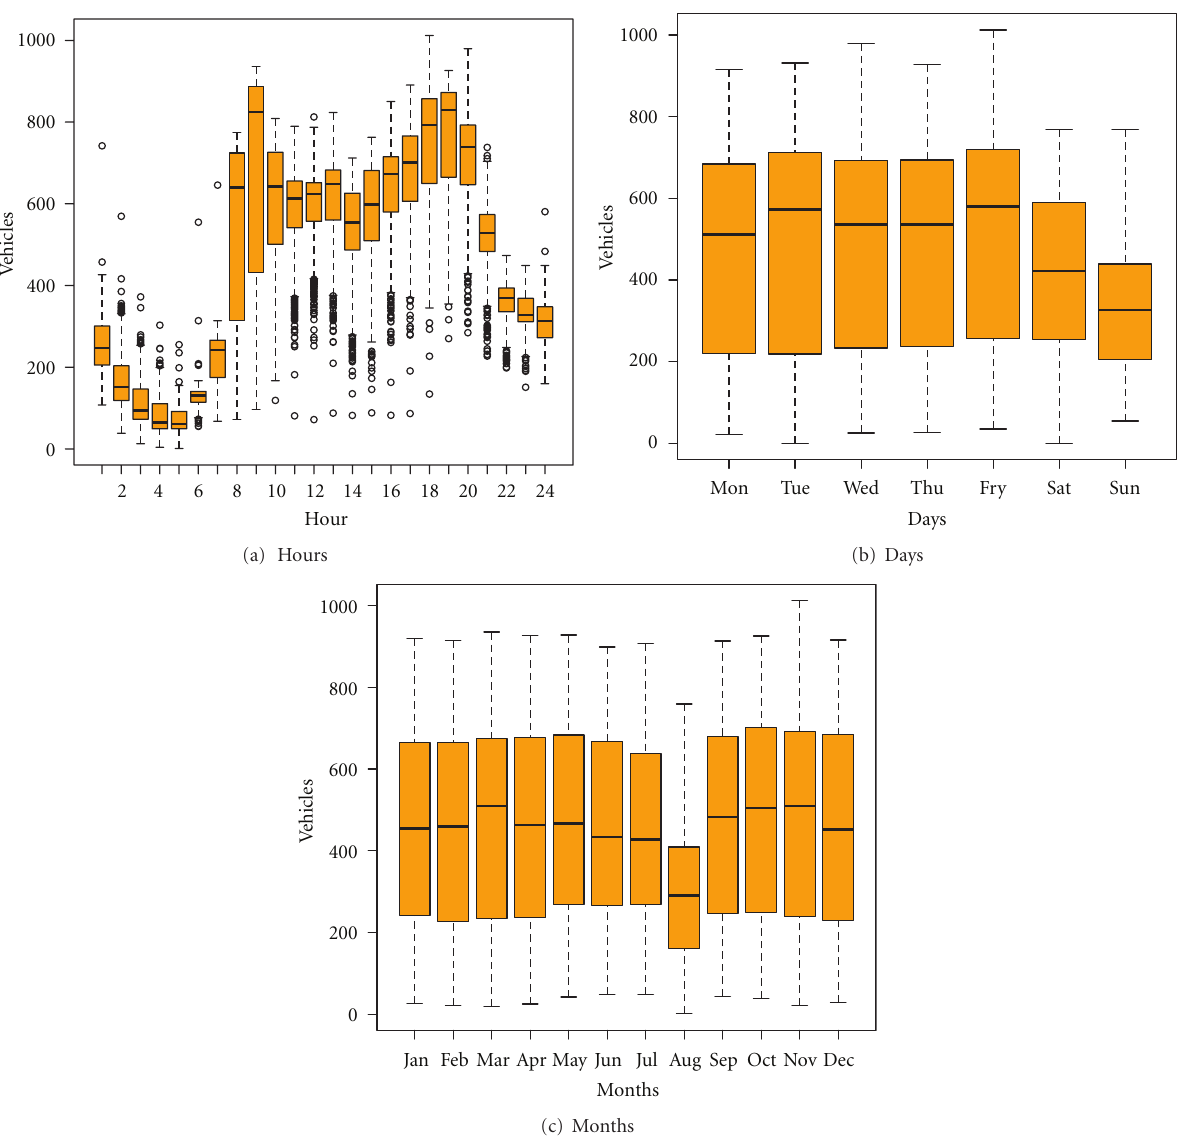
Figure 2: Box plots of the city-wide average tra ffi c volume for di ff erent time scale.